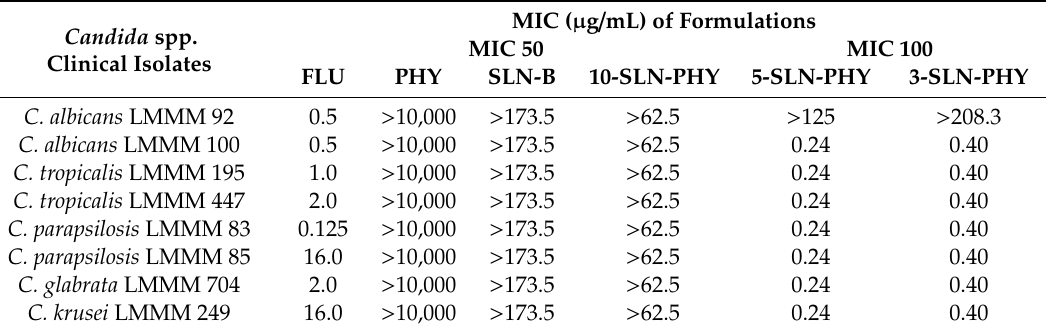
Table 3. Minimum inhibitory concentration values of phytol and SLN against Candida spp. clinical isolate strains determined with the broth microdilution assay. Candida